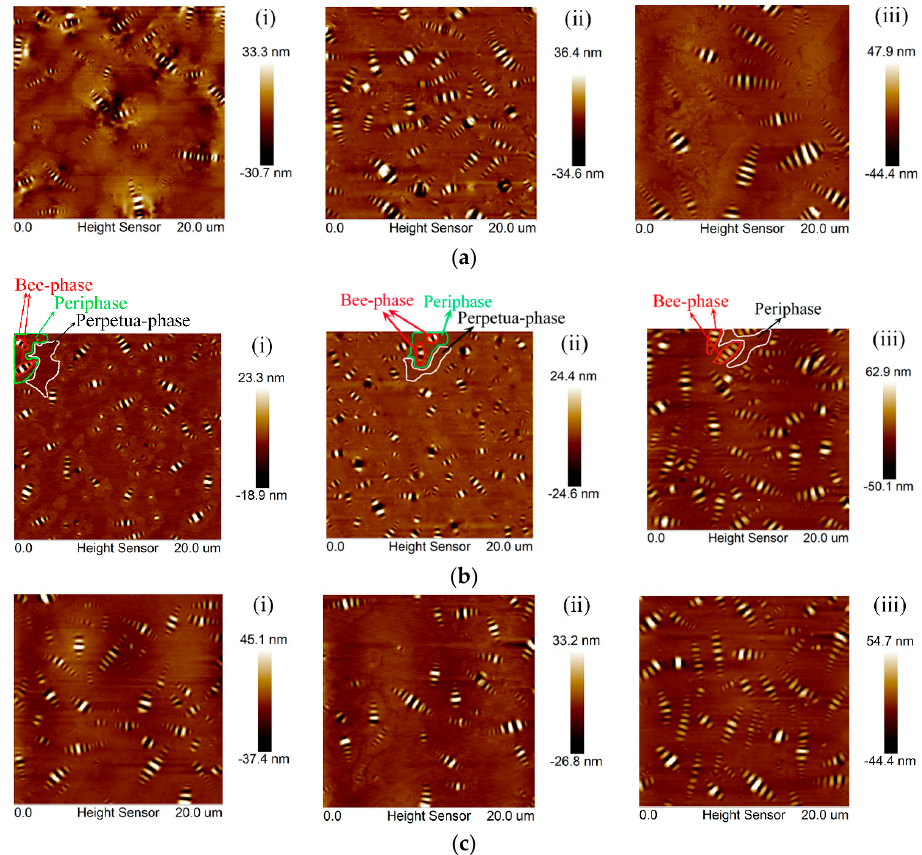
Figure 1. Topography of bitumen specimens before and after lab-simulated aging: ( a ) 70# bitumen; ( b ) 50# bitumen; ( c ) 30# bitumen, for ( i ) Virgin; ( ii ) rolling thin film oven (RTFO); ( iii ) pressure aging vessel (PAV).